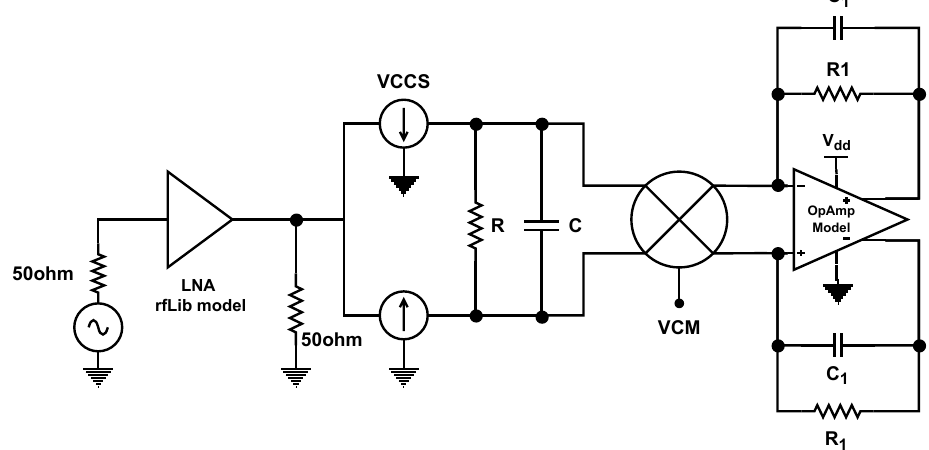
Figure 3. Test bench to design and optimize the down-conversion mixer switches.